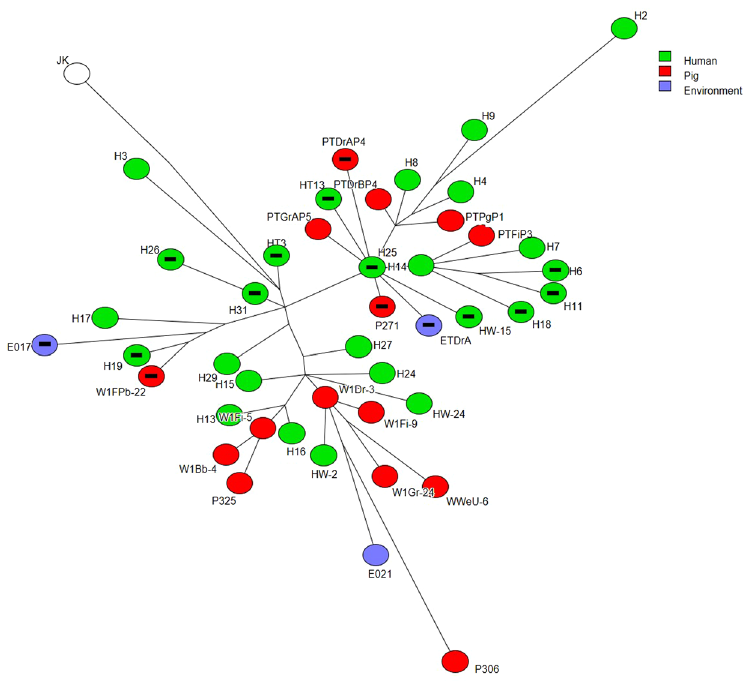
Figure 1. Phylogenetic tree constructed by core genome SNPs of MRSA ST93 isolated from humans, pigs and piggery environment. Each circle represents individual MRSAs. Isolates from humans, pigs, and environment are identified by green, red and purple colours respectively. Isolates that did not carry pvl gene are identified by a black bar in the